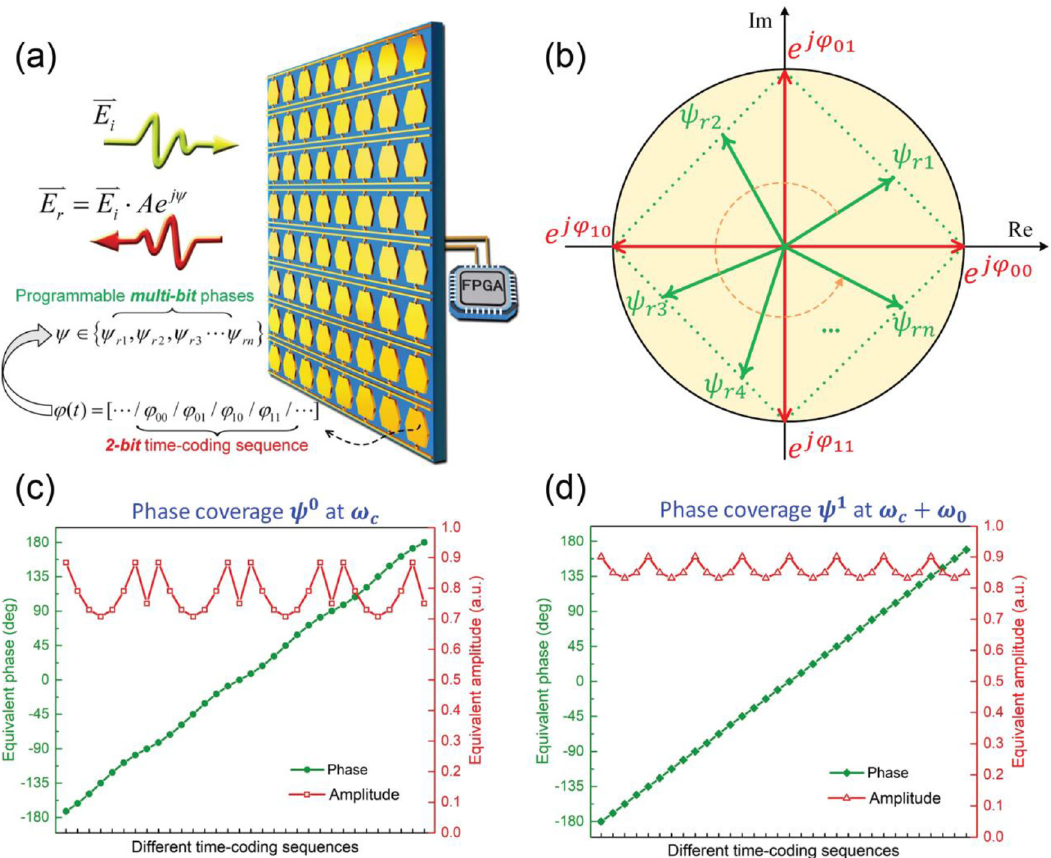
Fig. 4. Arbitrary multi-bit programmable phases (adapted from [29]). (a) Conceptual illustration. (b) Basic illustration of the vector synthesis method in the complex plane for the generation/analysis of multi-bit phases. (c, d) Equivalent phase coverage at the center angular frequency v c = 2 p f c and the fi rst harmonic v c + v 0 = 2 p ( f c + f 0 ), respectively, for a 2-bit time-coding sequences with length L